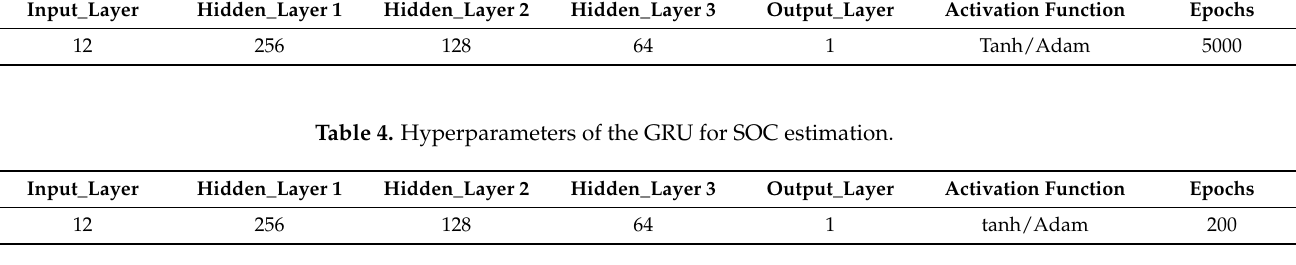
Table 7. The SOC errors obtained using the LSTM model generated by the proposed and conven- Table 5. Hyperparameters of the GBM for SOC tional methods.